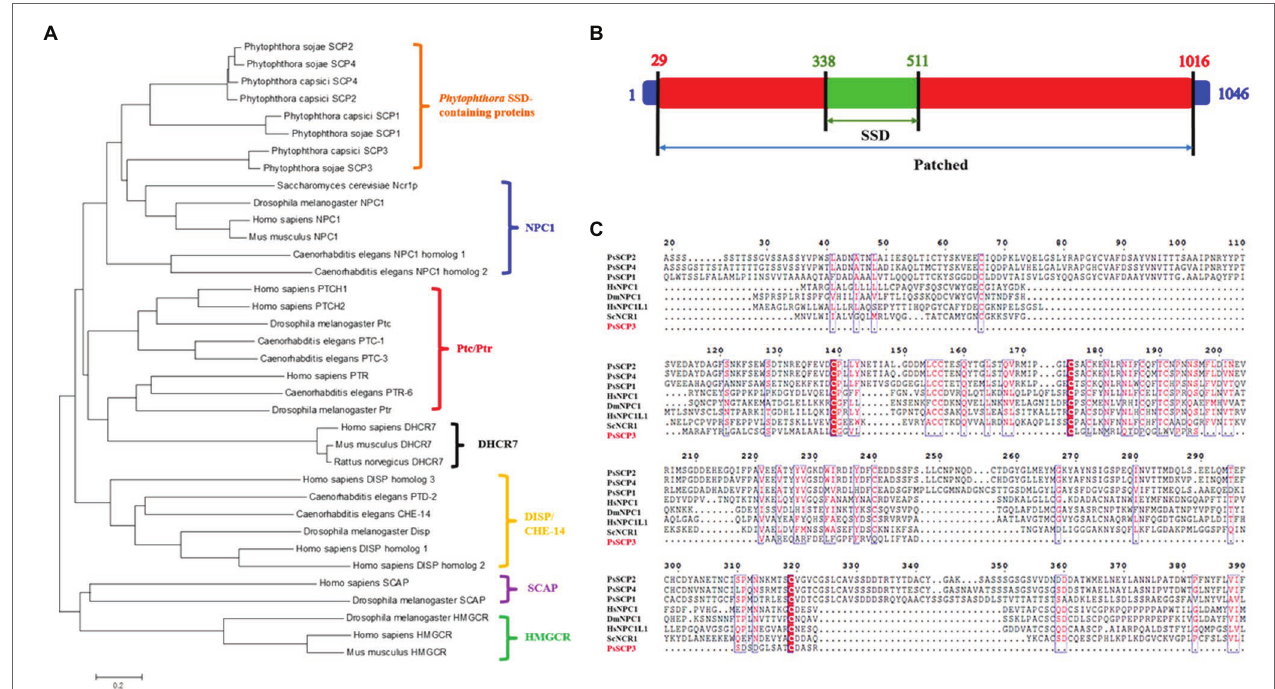
FIGURE 1 | Sequence characteristics of four putative PsSCPs. (A) Phylogeny analysis of PsSCPs with other SSD-containing proteins (SCPs) reported in different species. (B) Full length of PsPTL (PsSCP3) protein and location of the sterol-sensing domain (SSD) and Patched (Ptc) domain. (C) Multiple sequence alignment of N-terminal amino acid sequences of PsSCPs with deduced Niemann-Pick type C (NPC) domain of NPC-related proteins from other species, generated with Clustal W (Thompson et al., 1994; Hs, Homo sapiens ; Dm, Drosophila melanogaster ; Sc, Saccharomyces cerevisiae